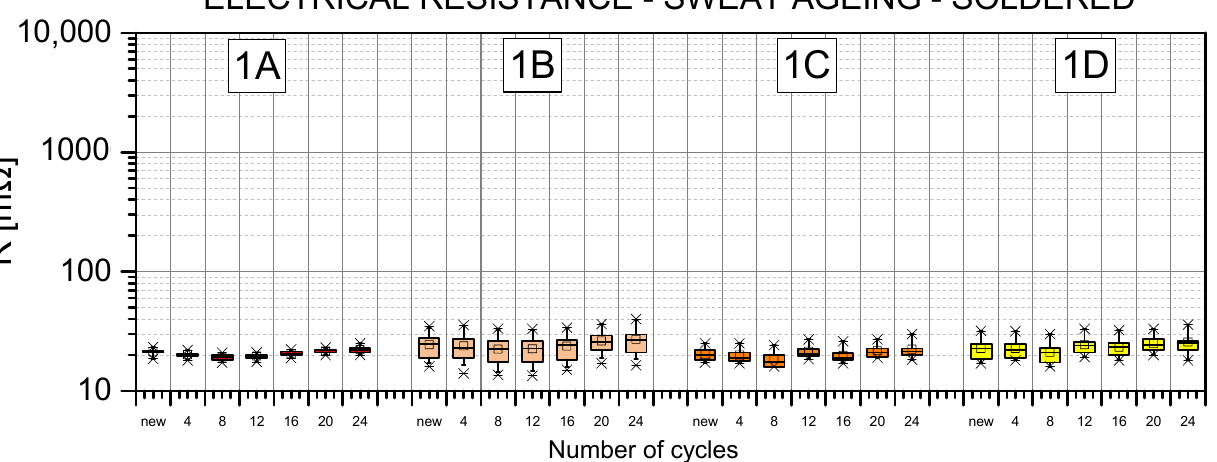
Figure 5. Procedure of conducting accelerated aging by artificial sweat test.